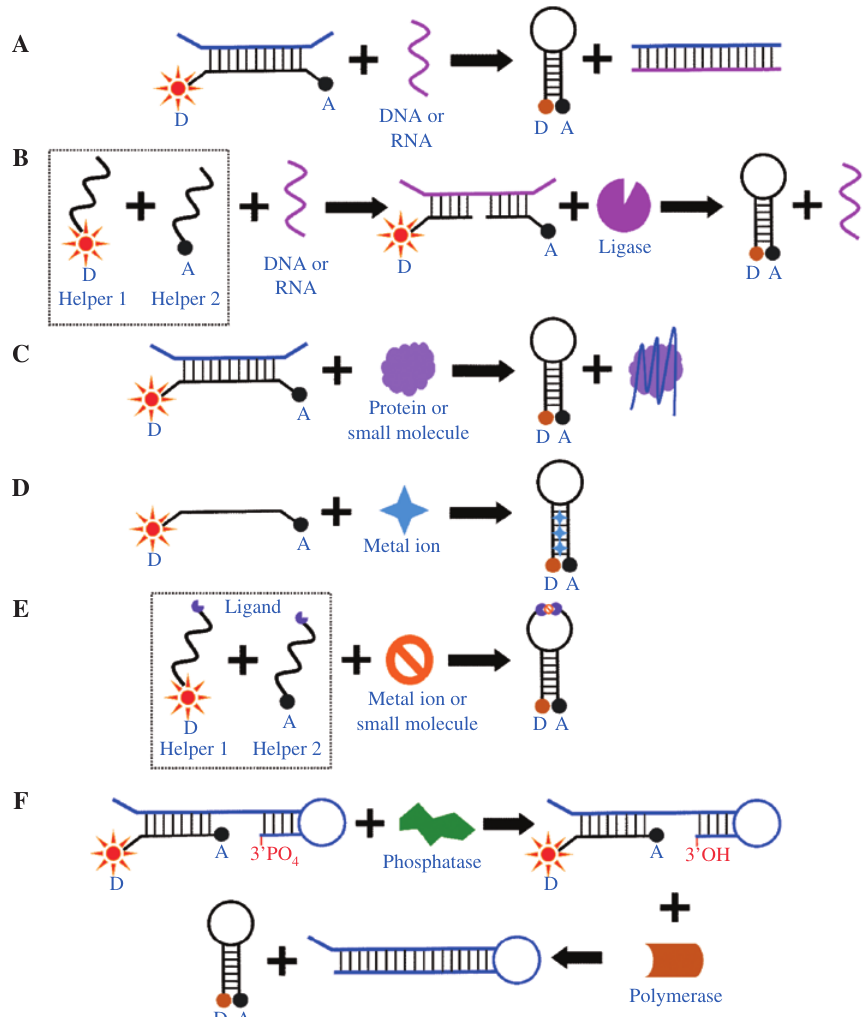
Figure 4: Schematic of the generic principles of MB-based homogeneous sensing systems (close-to-signal). Detection of nucleic acids (A and B), proteins or small molecules (C), metal ions (D and E), and phosphatase